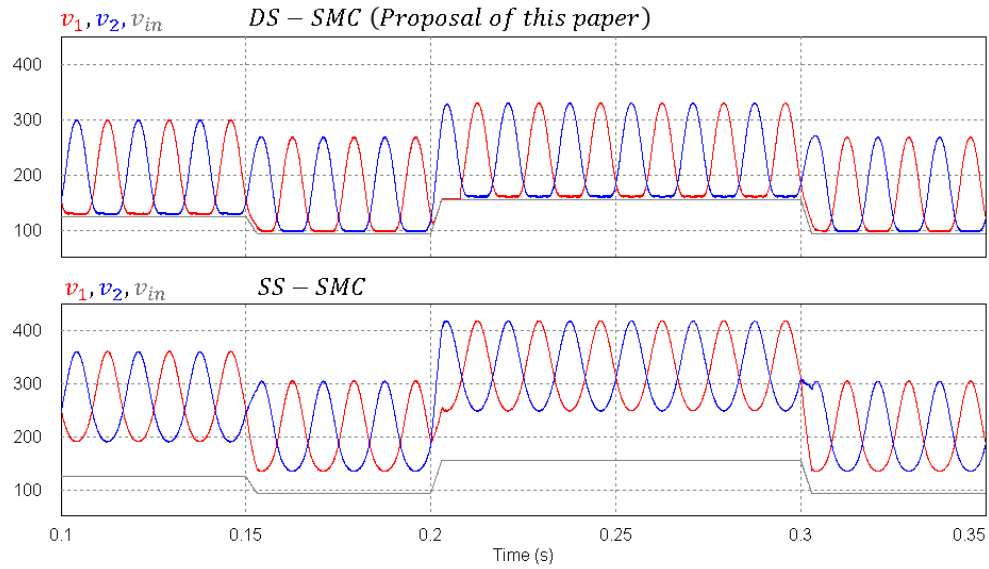
Figure 11. Simulated semiconductor voltages comparing SS-SMC and DS-SMC for simulation test 1.